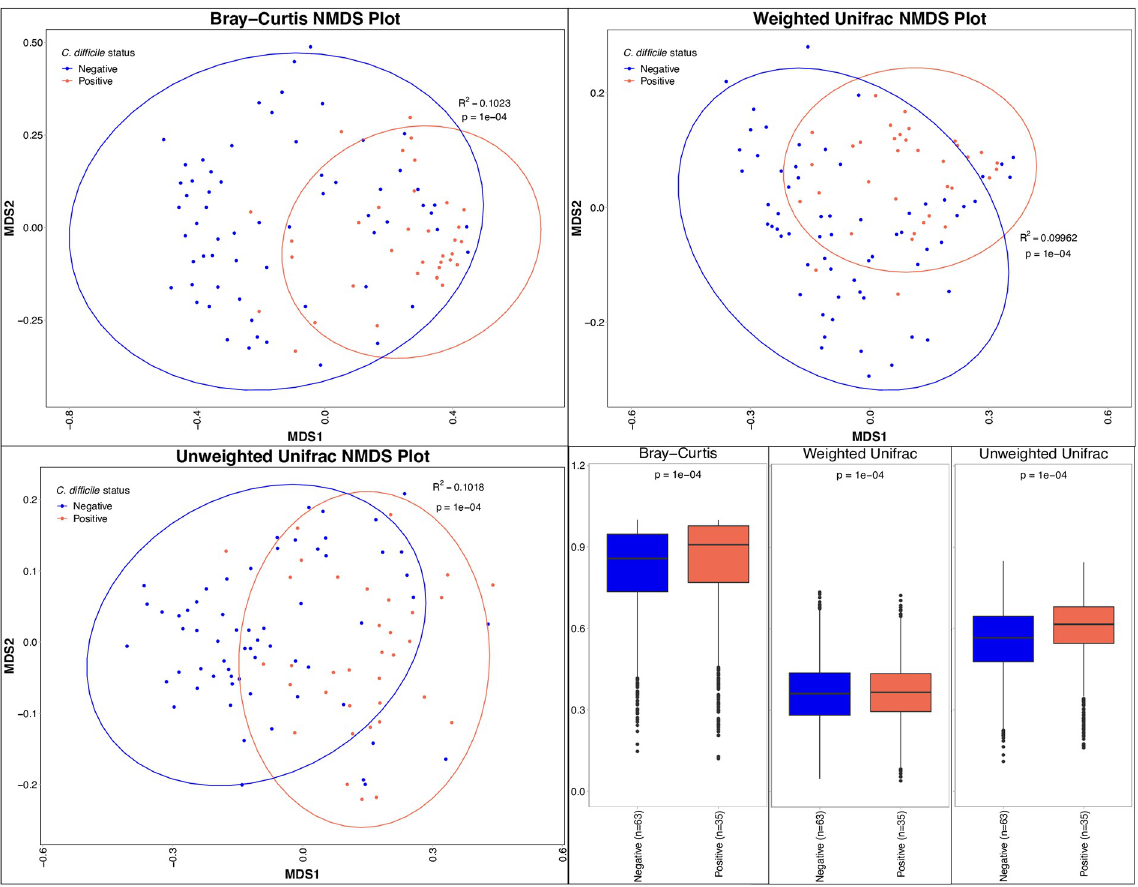
Fig 3. Non-metric Multidimensional Scaling (NMDS) plots and box plots show the dissimilarity in bacterial communities in C . difficile - positive and C . difficile -negative fecal samples from puppies in the greater Philadelphia area. Ellipses on NMDS plots display 95% confidence intervals. P-values were calculated using PERMANOVA. The dissimilarity among C . difficile positive puppies is displayed in the left boxplots and the dissimilarity between culture positive and negative puppies is displayed in the right boxplots. Boxes display the median, first and third quartiles, and whiskers extend to the minimum and maximum, while points represent outliers.